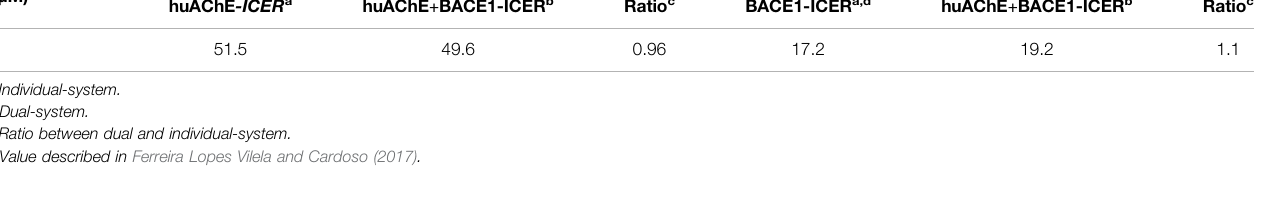
TABLE 2 | K Mapp values obtained for the dual and individual system assays. K Mapp values (µM)